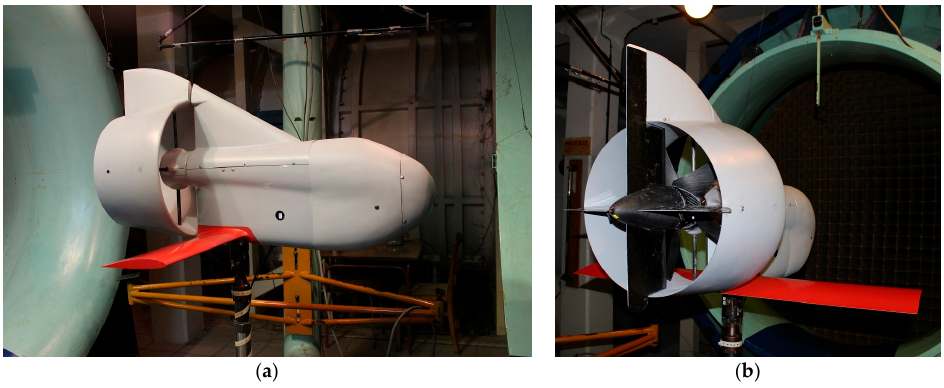
Figure 10. Test stand for propulsion testing. ( a ) Side view; and ( b ) aft view.